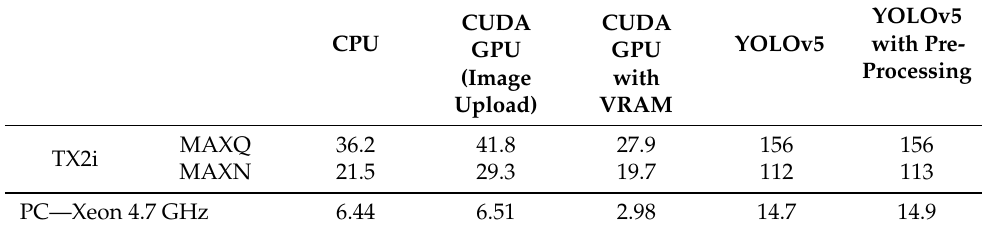
Table 4. Time of classification, in ms , with shadow recognition using FLD.